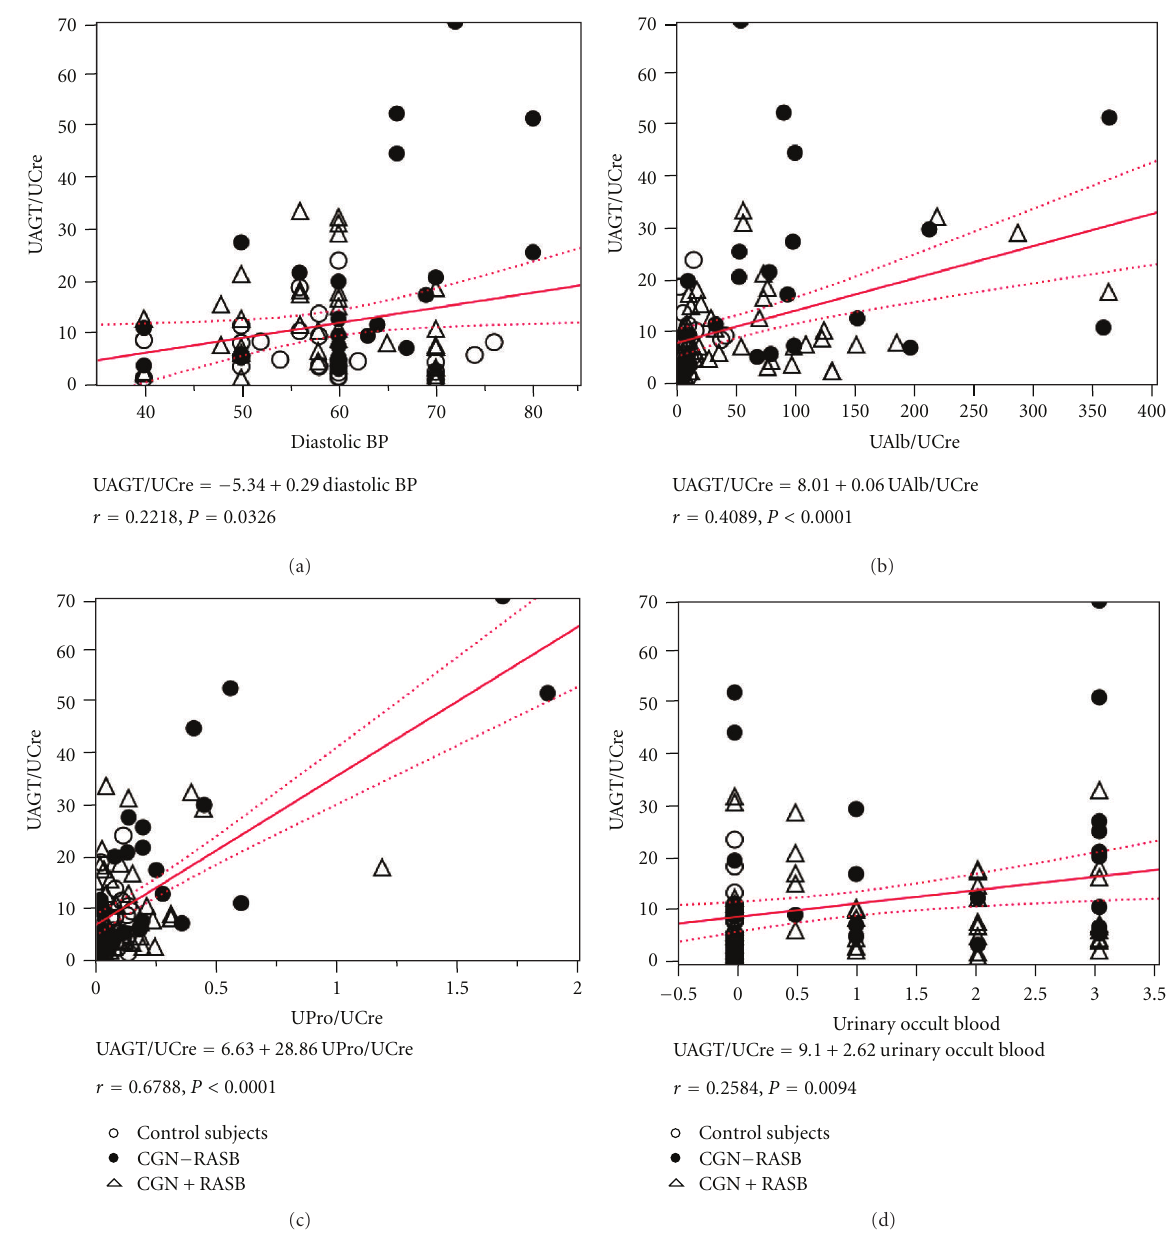
Figure 1: Single regression analyses for urinary AGT-creatinine ratio with diastolic blood pressure (a), urinary albumin-creatinine ratio (b), urinary protein-creatinine ratio (c), and urinary occult blood index (d), respectively, in chronic glomerulonephritis (CGN) patients with/without renin-angiotensin system blockade (RASB) and in control subjects. Cited from Am J Nephrol 2010; 31: 318–325 by Urushihara et al.